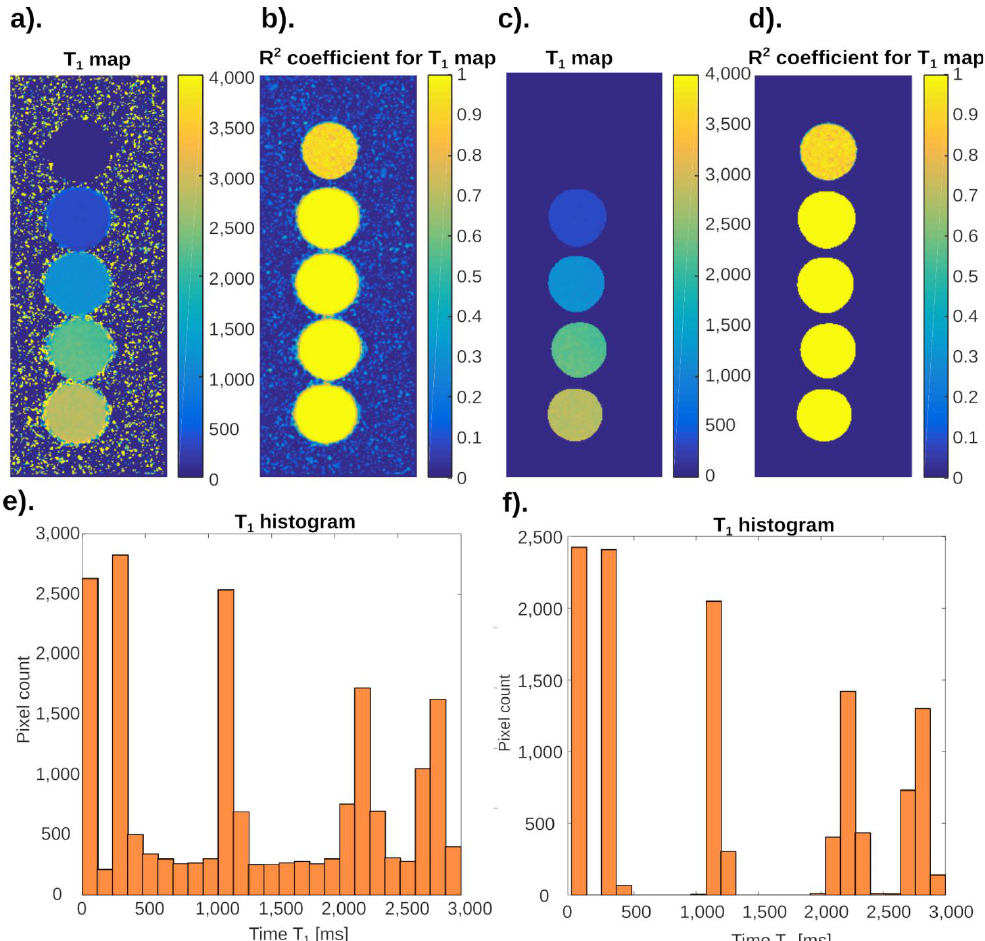
Figure 3. Distribution of T 1 relaxation time values for the tested phantom, the color of each pixel corresponds to the T 1 value that was measured for a specific pixel in a series of DICOM images: ( a ) the distribution of T 1 times before the analysis with the neural network; ( b ) the distribution of fit coefficient R 2 values before the neural network analysis; (c) the distribution of T 1 times after the analysis with the neural network; ( e ) histograms of T 1 times from images before the analysis with the neural network; (f) histograms of T 1 times from images after the analysis with the neural net- work.